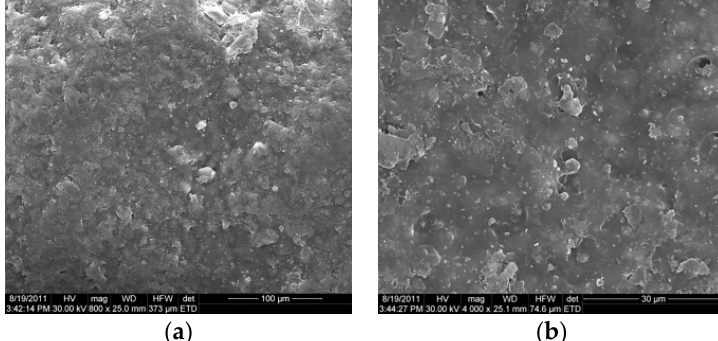
Figure 5. ( a ) SEM image (800 × ) of the surface of MXA; ( b ) SEM image (4000 × ) of the surface of MXA.